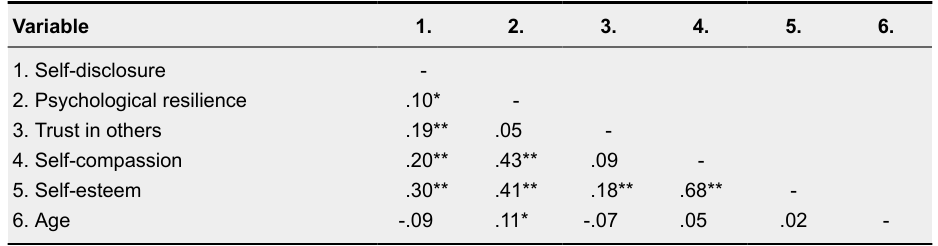
Correlations Among Study